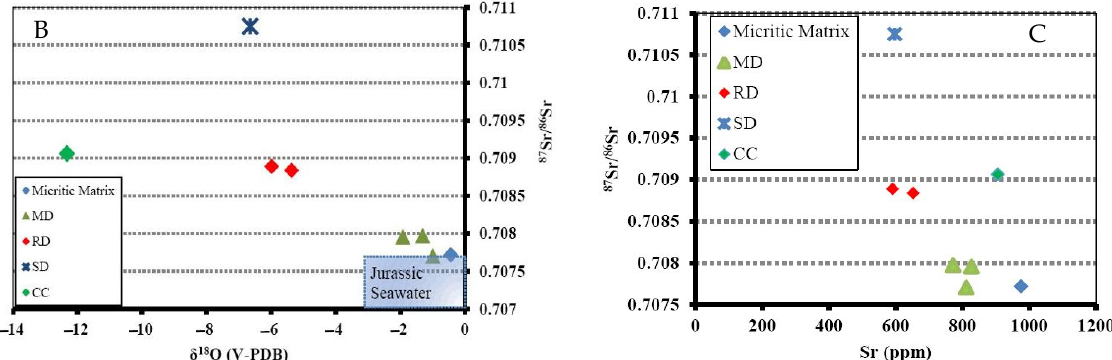
Figure 8. ( A ) 87 Sr/ 86 Sr curve for the seawater of the Mesozoic era (redrawn after McArthur, Howarth, and Shields [51]). ( B ). Cross-plot between δ 18 O values versus 87 Sr/ 86 Sr for the different diagenetic phases. The blue box indicates the Jurassic marine seawater signatures of NW Tethys compiled by Al-Mojel, Dera, Razin, and Le Nindre [50]. ( C ). There is a cross-plot between Sr concentration and 87 Sr/ 86 Sr of different dolomite and calcite phases. RD-I: matrix dolomite, RD-II: replacive dolomite, SD: saddle dolomite, CC: fracture-filling dolomite.